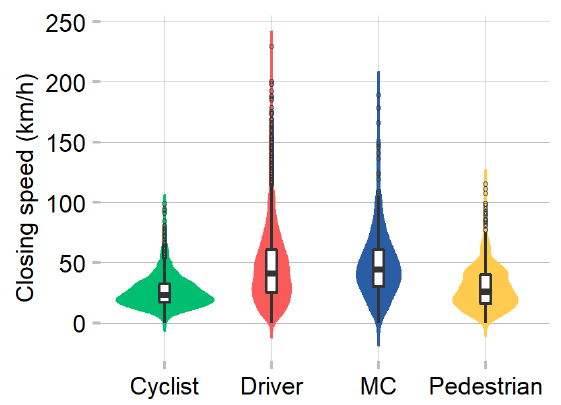
Figure 1. Closing speed distribution for road users. MC: motorcyclist. A boxplot (depicting the median as a solid line, Q1-Q3 as box whiskers up to 1.5 times the interquartile range, and potential outliers as points) is embedded in a violin plot (a visualization of the kernel density estimate, a smoothed version of the histogram).